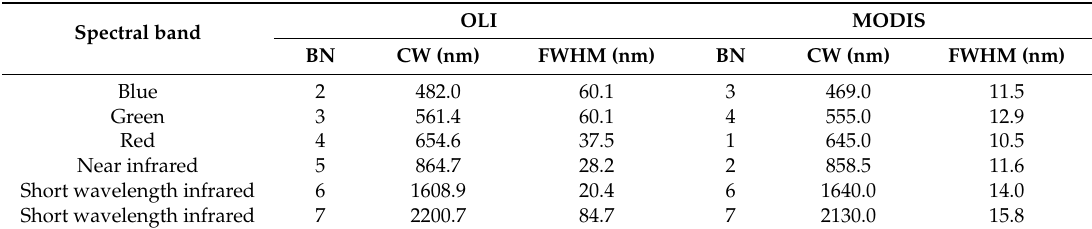
Table 1. Band numbers (BN), central wavelengths (CW), and full width at half maximum (FWHM) of the OLI and MODIS sensors for the selected spectral bands.